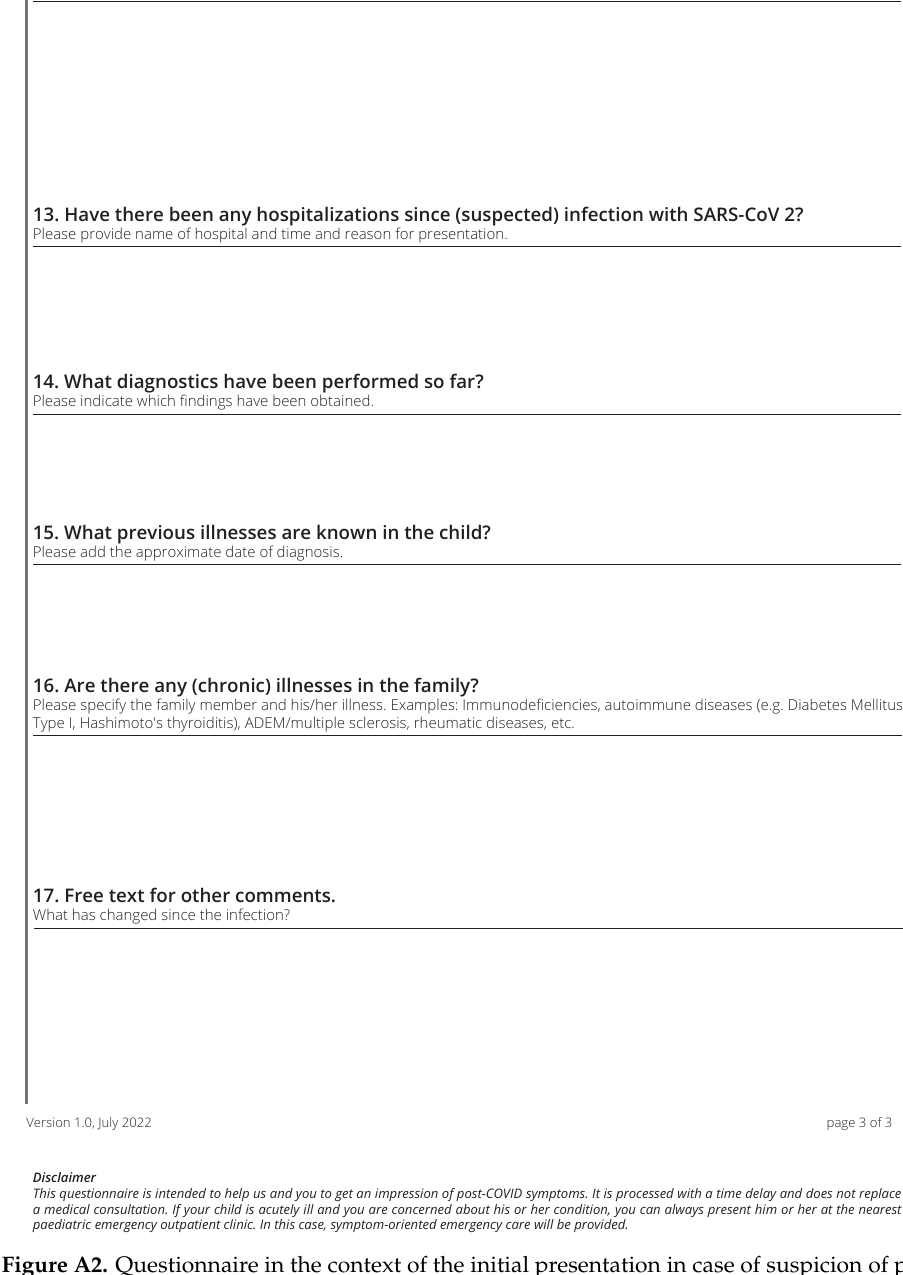
Figure A2. Questionnaire in the context of the initial presentation in case of suspicion of pediatric